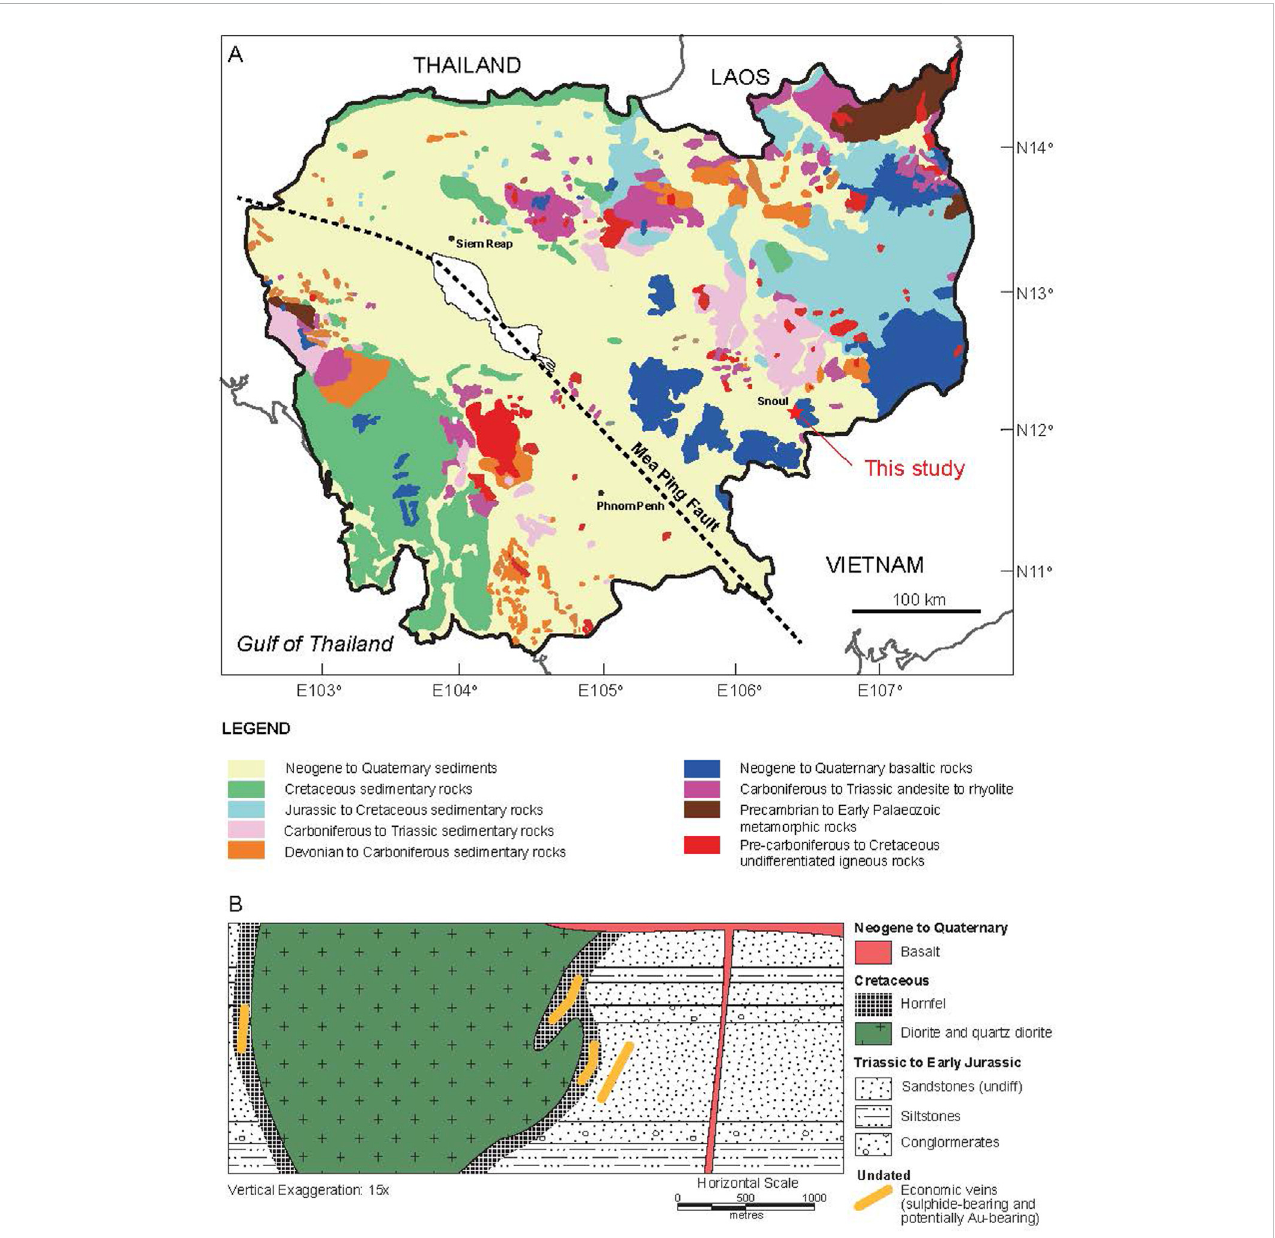
FIGURE 2 (A) Geological map of Cambodia showing the location of the Snoul pluton (modi fi ed from Kasahara et al., 2021). (B) Schematic cross-section of the region underneath the Snoul pluton (green) highlighting the stratigraphic relationships of various lithological units.